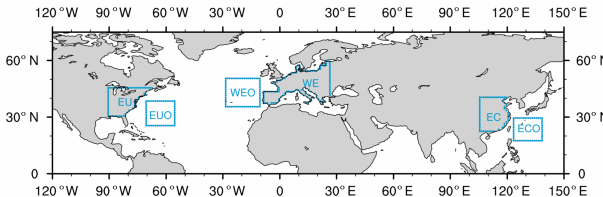
Figure 1. Regions analyzed in this study: three anthropogenic re- gions (EC, EU, and WE) and their adjacent oceans (ECO, EUO, and